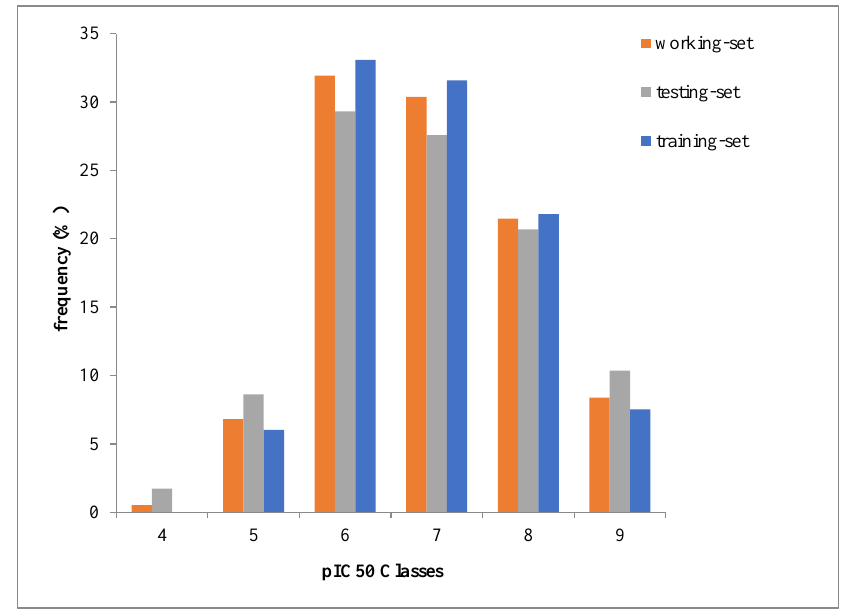
Figure 1. pIC 50 values distribution in the training and test sets.